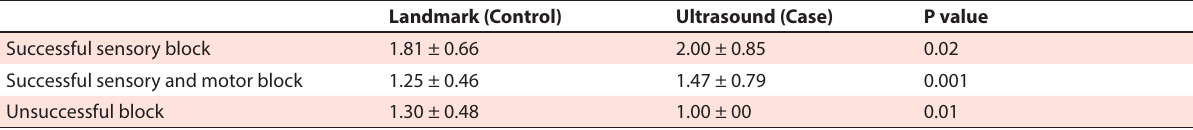
Table 1. Comparison of nerve blocking success between the patients undergoing landmark-based and ultrasound-guided methods 15 minutes post-intervention Landmark (Control)